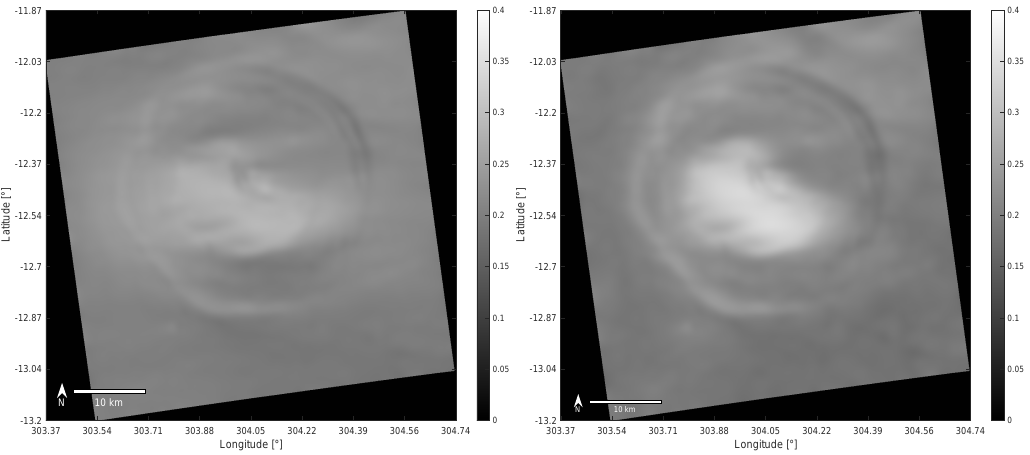
Figure 5. ( a ) In the first iteration, the process underestimates the albedo of the hollows, which leads to fuzzy borders. ( b ) After the fourth iteration, the borders are more pronounced and modeled with a higher